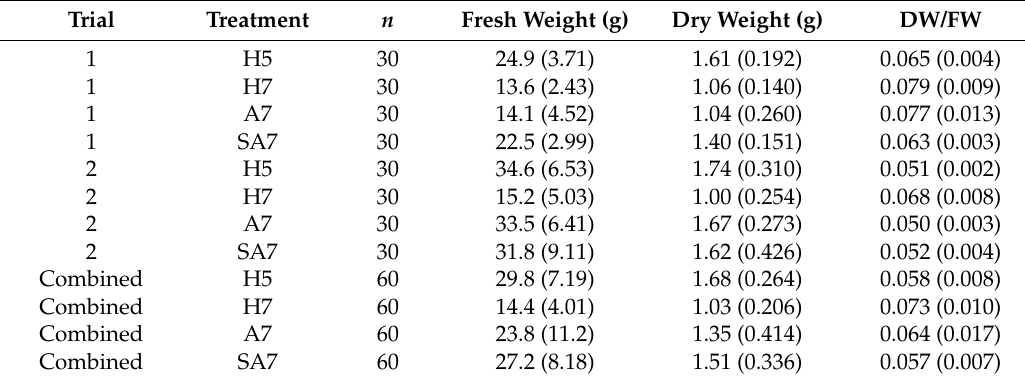
Table 4. Summary data for shoot fresh and dry weights (g) and for dry weight to fresh weight ratio (DW/FW), separated by treatment and trial. For the last three columns, values to the left are mean values, while values in parentheses are standard deviations.